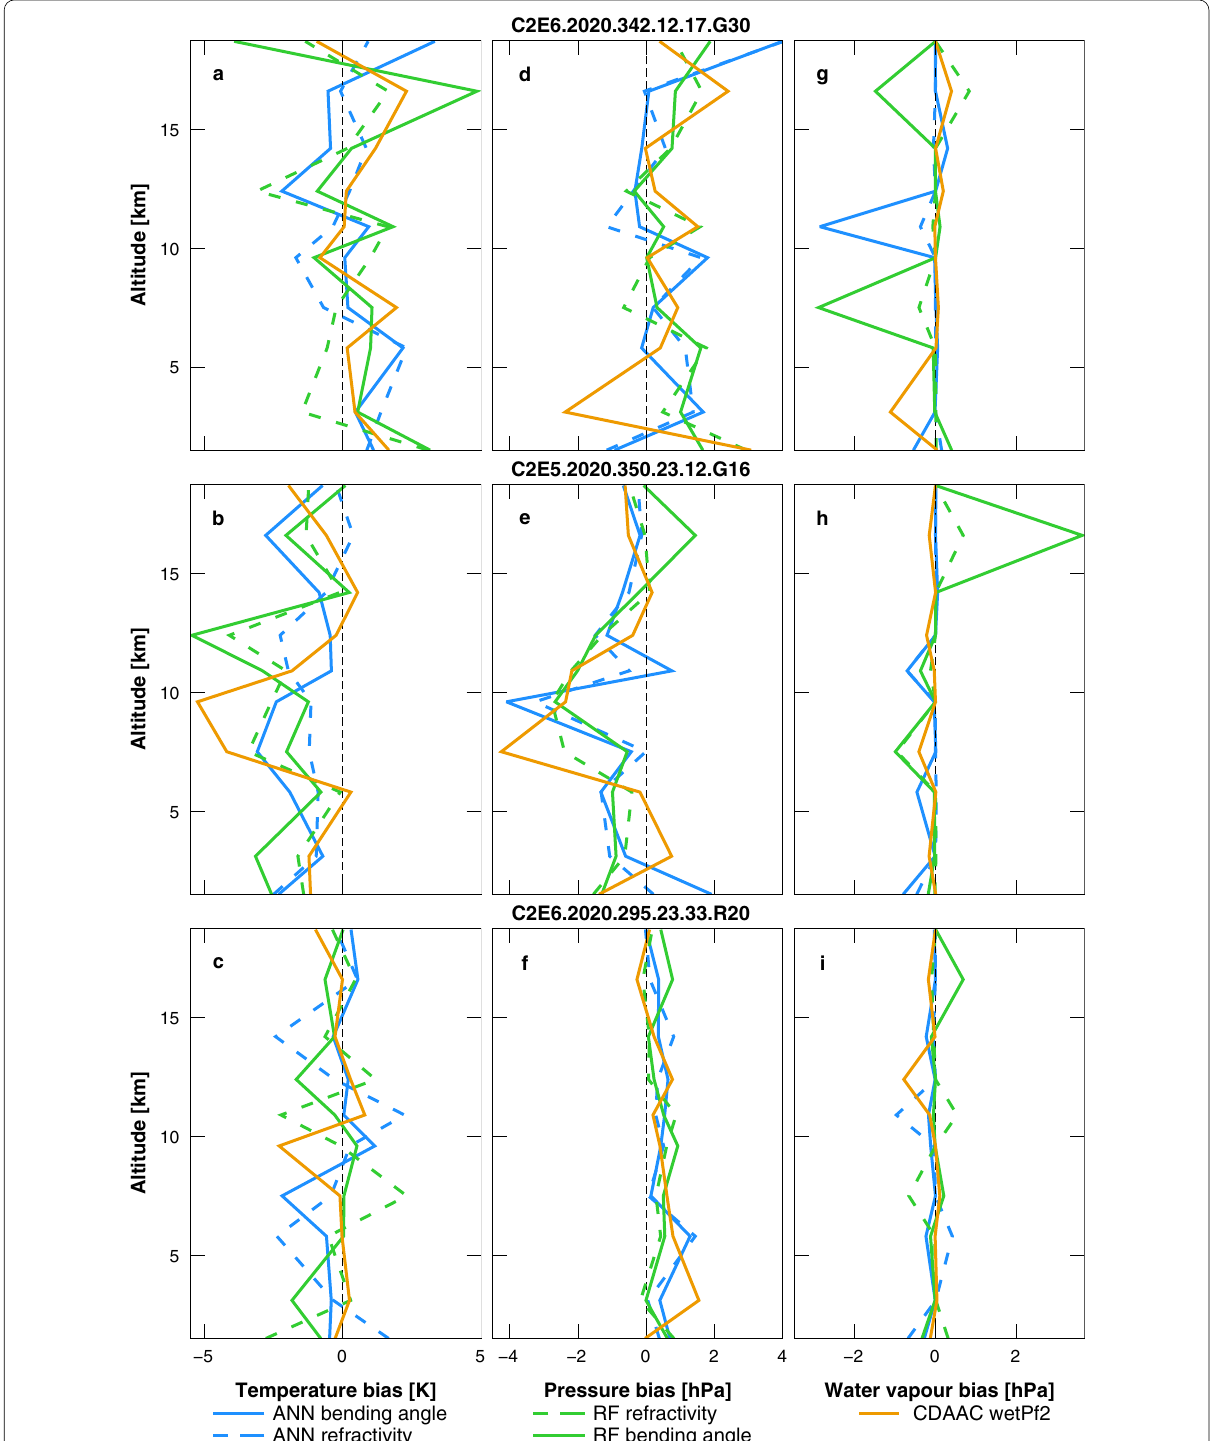
Fig. 7 Validation results for temperature ( a – c ), pressure ( d – f ) and water vapor partial pressure ( g – i ). Vertical profiles show differences between co-located RAOBs and RO retrievals obtained using different machine learning models or 1DVar approach contained in the official wetPf2 CDAAC product for radiosonde stations in Topeka (top panels), Delhi, Safdarjung (middle panels) and Legazpi, Luzon (bottom panels). Bold titles indicate the CDAAC profile ID and vertical dashed lines represent zero